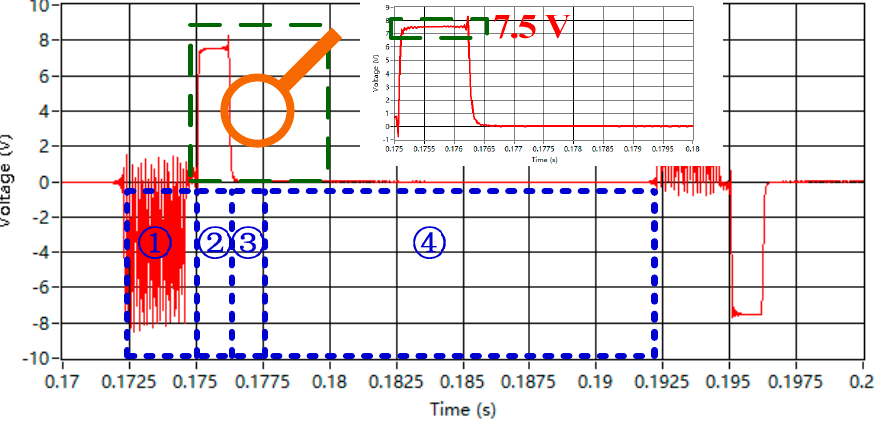
Figure 15. Waveform captured from the helicopter TEM system.